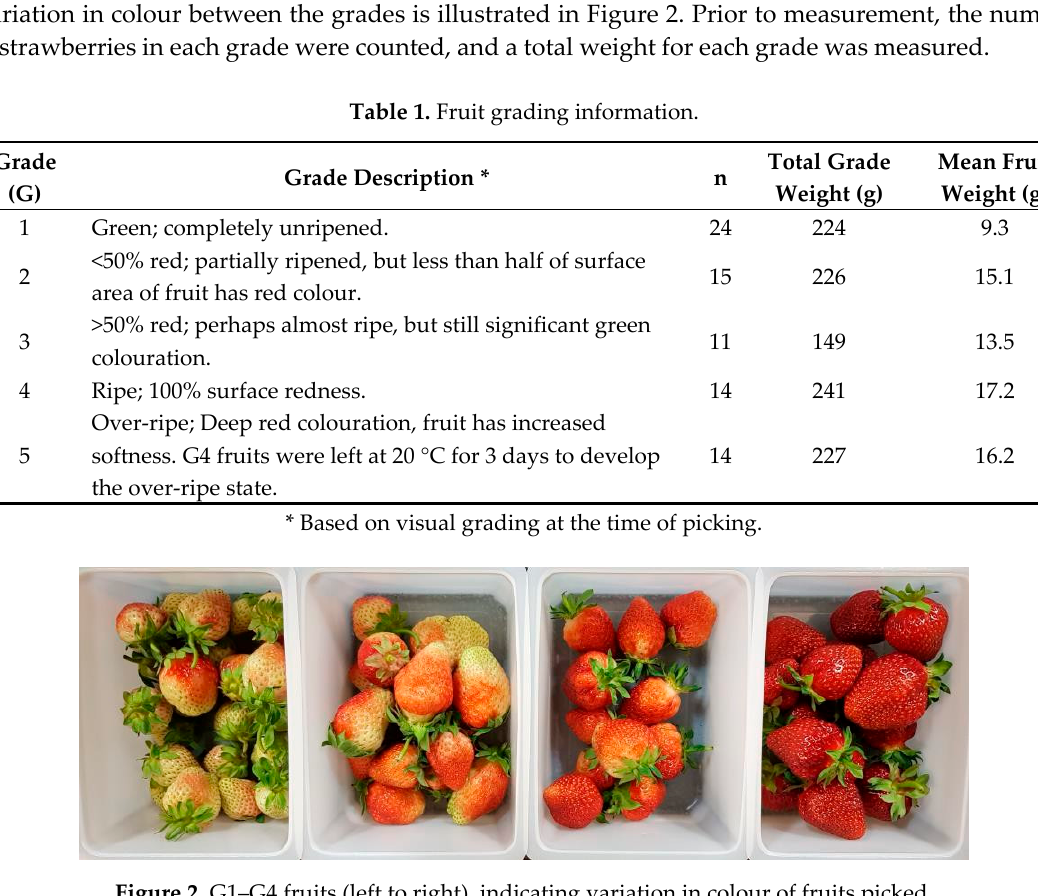
Figure 2. G1–G4 fruits (left to right), indicating variation in colour of fruits